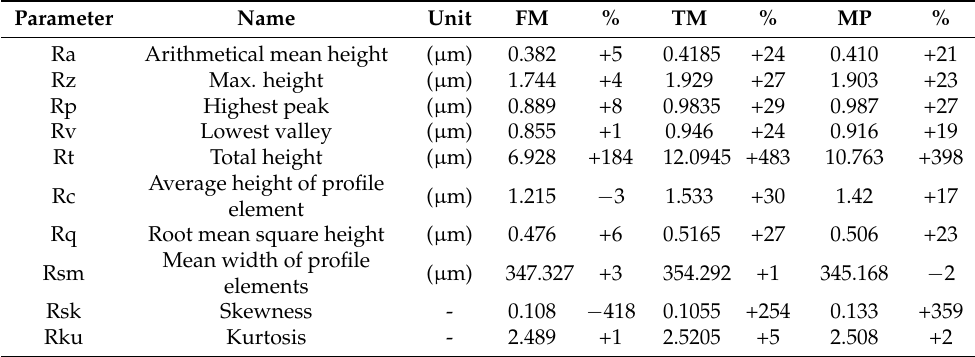
Figure 13. 2D surface roughness of the tested materials from radius 105 mm, 45 ◦ after 11.4 km run ( a ) unworn, ( b ) FM, ( c ) TM, ( d ) MP. Table 20. Surface roughness parameters of the tested materials after 180 h testing on radius 105 mm with 45 ◦ impact angle and the change in